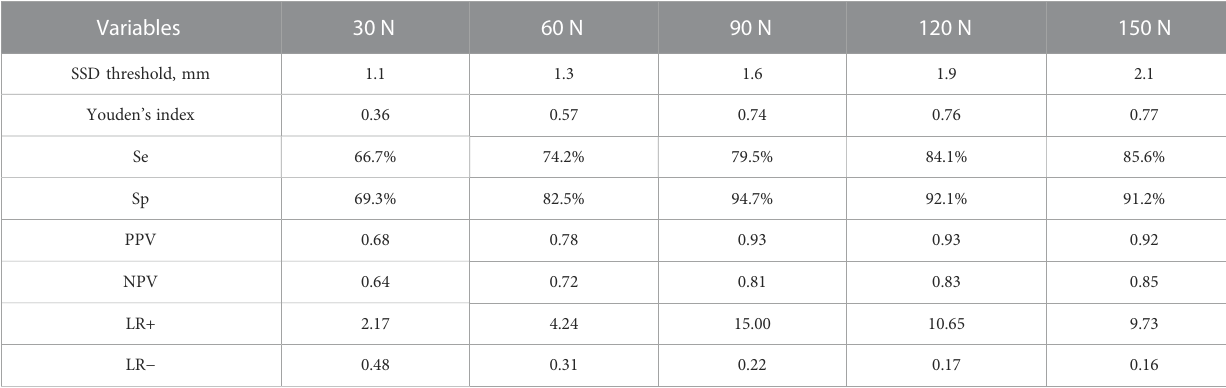
TABLE 2 Results of the ROC curve analysis for the Ligs Digital Arthrometer.